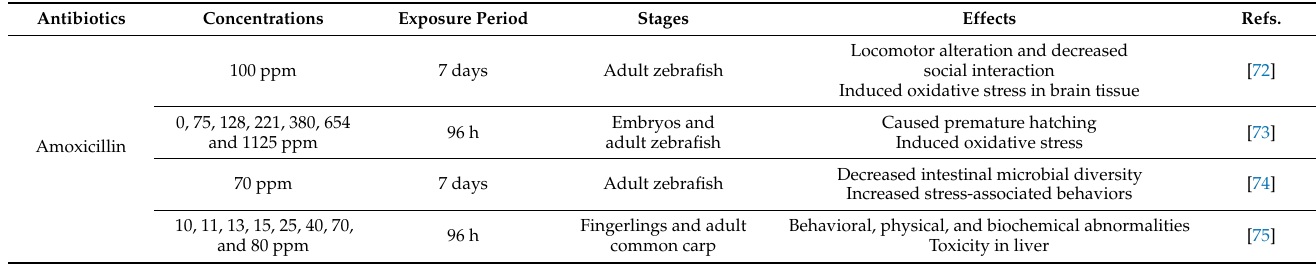
Table 1. Previously reported toxicological effects of amoxicillin, trimethoprim, and tylosin on aquatic